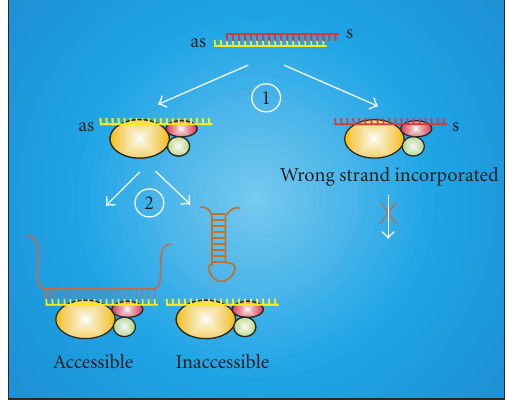
Figure 3: E ffi ciency of an siRNA is determined at two points of the RNAi pathway. (1) A strand bias exists that is defined by the intrinsic thermodynamic properties of the siRNA duplex, that is, by the rel- ative stability of both ends. (2) A highly ordered structure may have a detrimental influence on the hybridisation of the siRNA/RISC to its target site and may therefore reduce the e ffi ciency of the silenc- ing process, even in cases in which the intended antisense strand is favored for incorporation into RISC. (Reprinted with slight modi- fications from the Journal of Molecular Biology; see [42], with kind permission from Elsevier.)